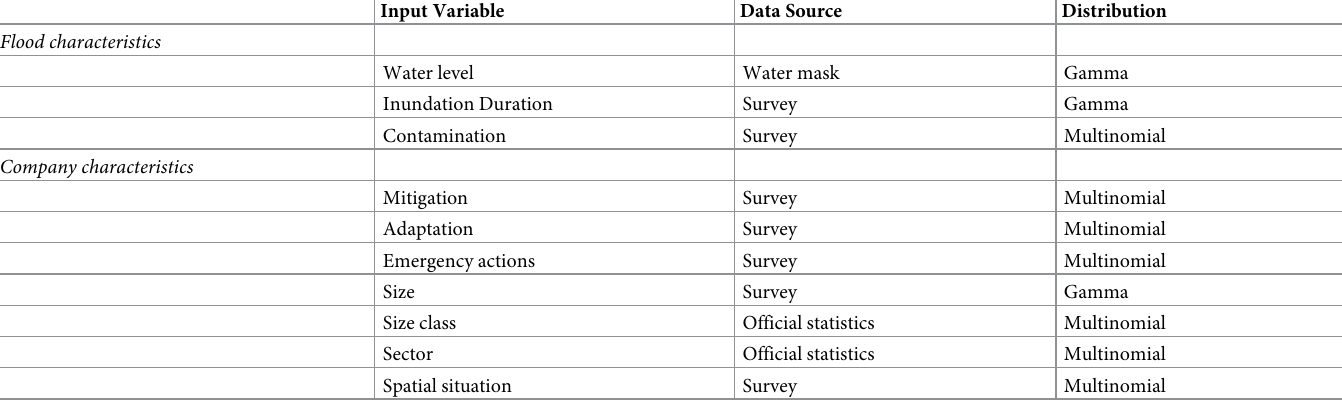
Table 3. Input variables used by the Random Forests for the estimation of the direct economic impacts and the distributions used to simulate these variables as well as data